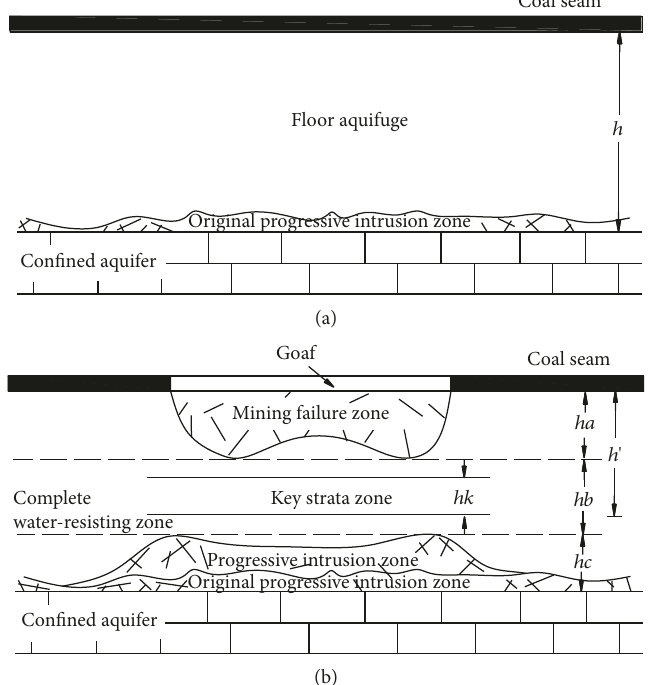
Figure 1: Schematic map of fl oor damage during fi rst pressure in mining above the con fi ned aquifer. (a) Original intrusion zone of con fi ned water before mining. (b) Intrusion zone of con fi ned water, failure zone of the fl oor, and key strata.